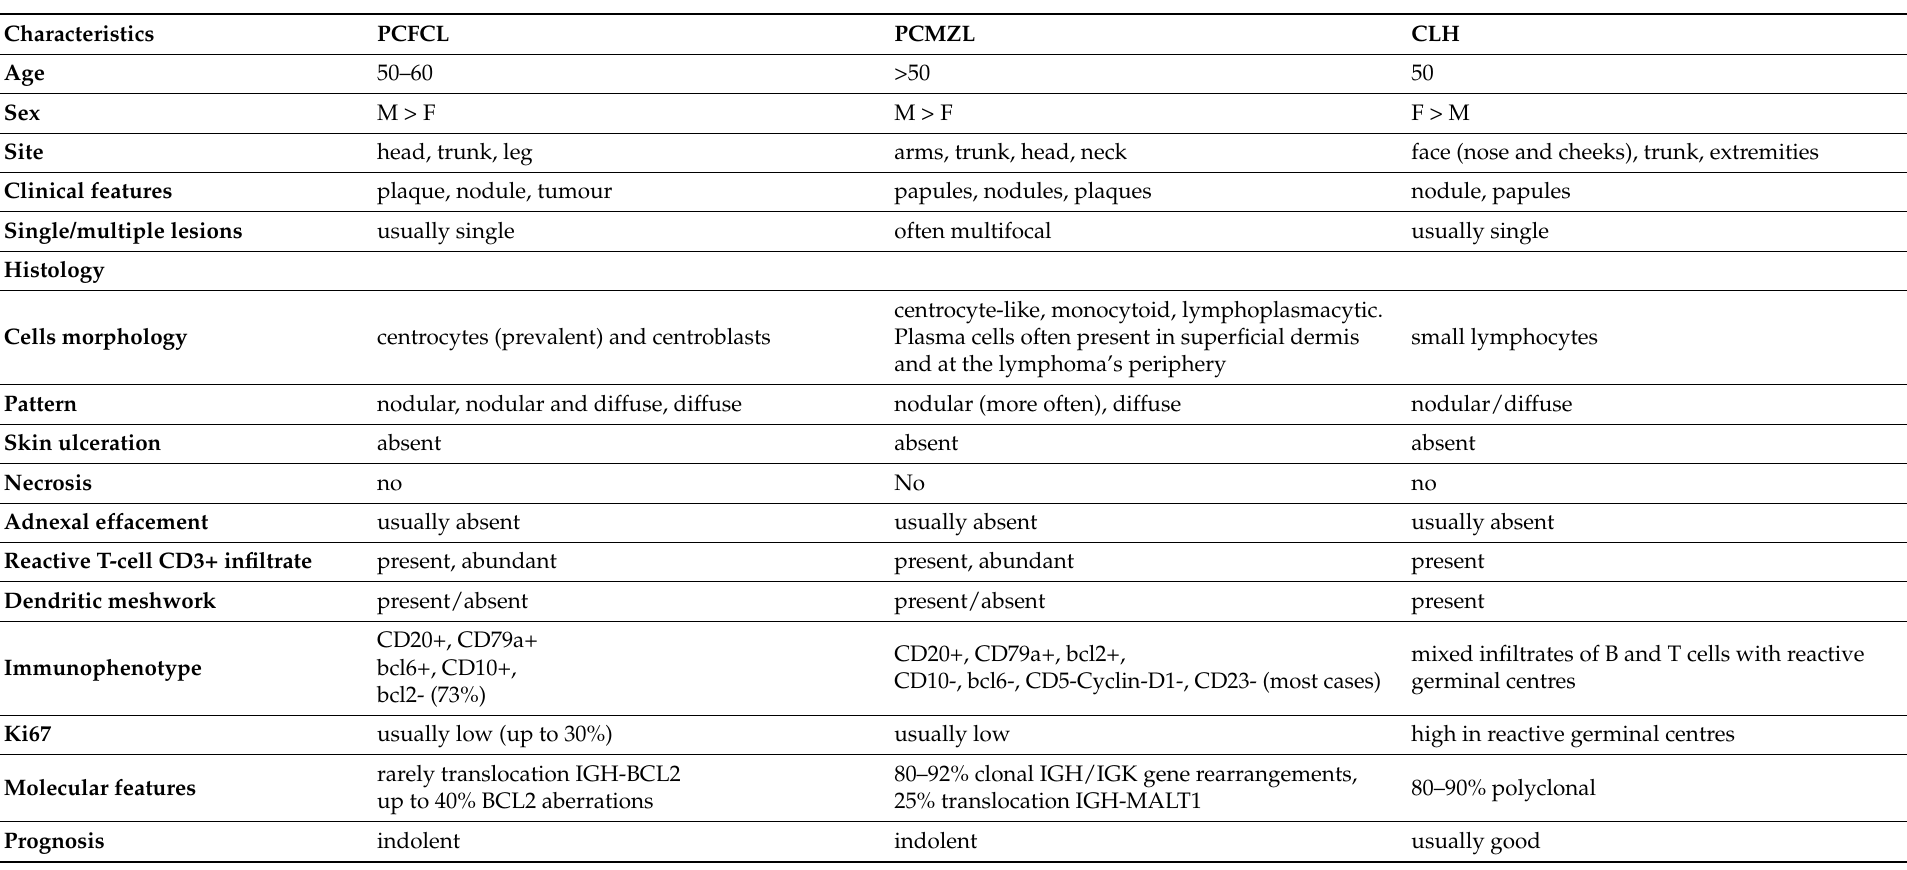
Table 1. Differential diagnosis between PCFCL, PCMZL and